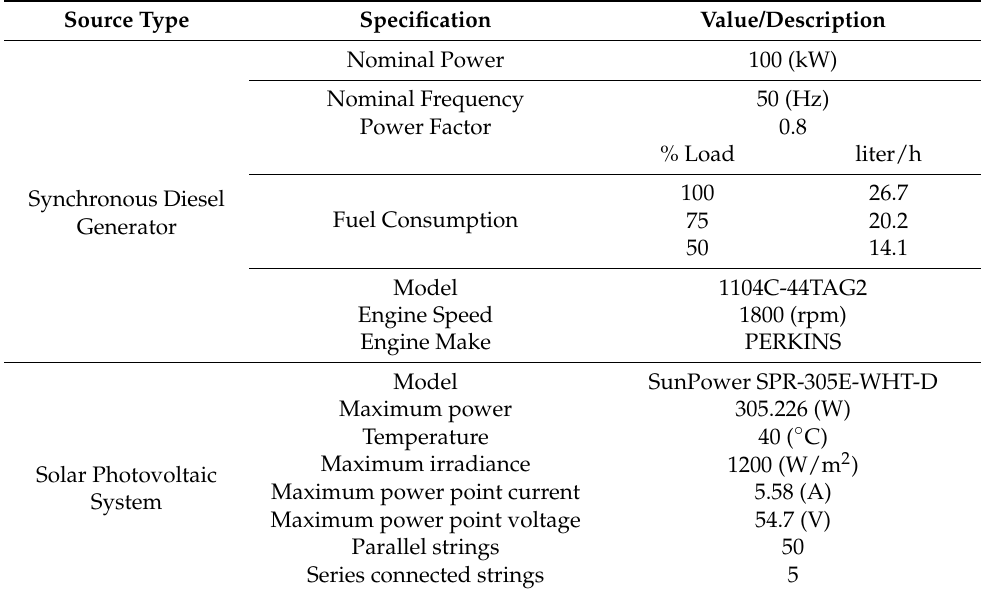
Table 2. Parameter specifications of DGen and the PV system used in proposed PVHMS.